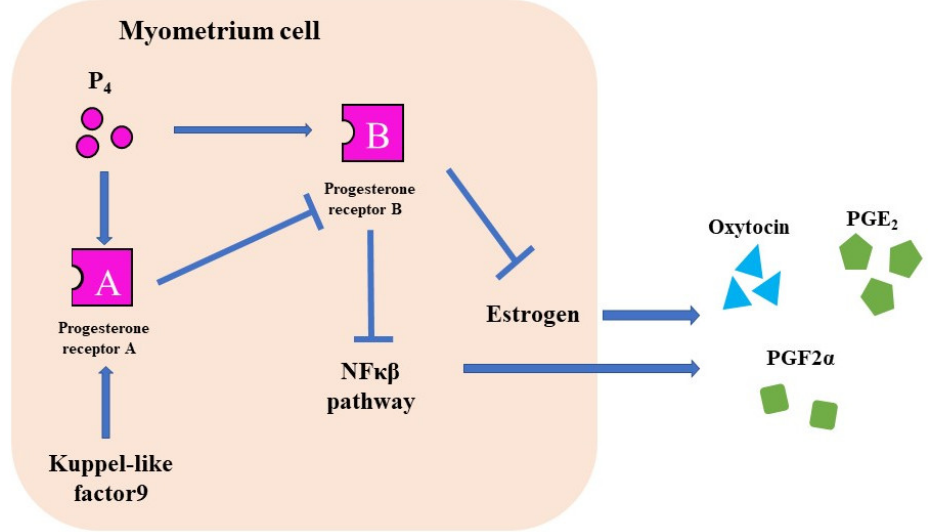
Figure 4. The function of P₄ receptors. There are two types of PRs. PR-B suppresses CAPS and maintains pregnancy. PR-A induces labor induction by suppressing the PR-B.